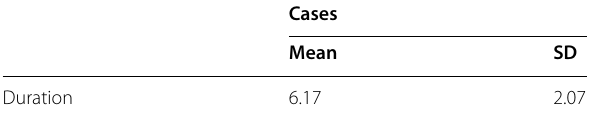
Table 3 Duration of illness in group of patients